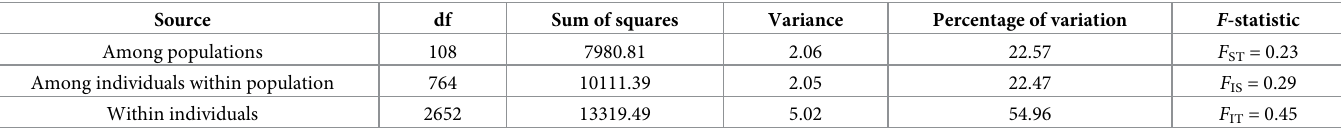
found to have mixed ancestry of more than one genetic cluster (Fig 2). Five populations, FJ, BW, DL, KF and MR, were dominated by one genetic subpopulation. In LM and JX, two genetic subpopulations were represented in roughly equal proportions. Lastly, in JF, QW and BL, all three genetic subpopulations were represented, with one cluster (red, III) dominated (Fig 1). Geographically, individuals assigned to the same genetic cluster were widespread, and the distributions of the three genetic clusters were overlapping (Fig 1). The genetic relationships among H . hainanensis individuals were further explored using PCoA, and the results were consistent with the STRUCTURE analysis (Fig 3). The first two principal coordinates explained 43.89% of the total genetic variance (27.69% and 16.21%, respectively). Three genetic groups with clear boundaries were identified, corresponding to the three genetic components determined in the STRUCTURE analysis. In addition, using Cavalli-Sforza’s (1967) chord distances, a neighbor-joining tree was constructed. In the tree, individuals were divided into three groups, again in agreement with the three genetic groups identified by both PCoA and STRUCTURE (S2 Fig). The distribution of allele frequencies in H . hainanensis is obvious distorted and different from the other three dipterocarp species (Fig 4). The number of alleles at low frequency ( < 0.1) was equal to the number of alleles at intermediate frequency (0.101–0.200) in H . hainanensis . However, the alleles at low frequency ( < 0.1) are much more abundant than those at interme- diate frequency (0.101–0.200) in the other two non-threatened Shorea species. Such a mode- shift distortion of allele frequency distribution is a characteristic of bottlenecked populations, revealing that H . hainanensis on Hainan Island may have undergone a recent population bottleneck. Table 4. Analysis of molecular variance (AMOVA) for Hopea hainanensis populations. Source df Sum of squares Variance Percentage of variation F -statistic Among populations 108 7980.81 2.06 22.57 F ST = 0.23 Among individuals within population 764 10111.39 22.47 F IS = 0.29 Within individuals 2652 13319.49 54.96 F IT =